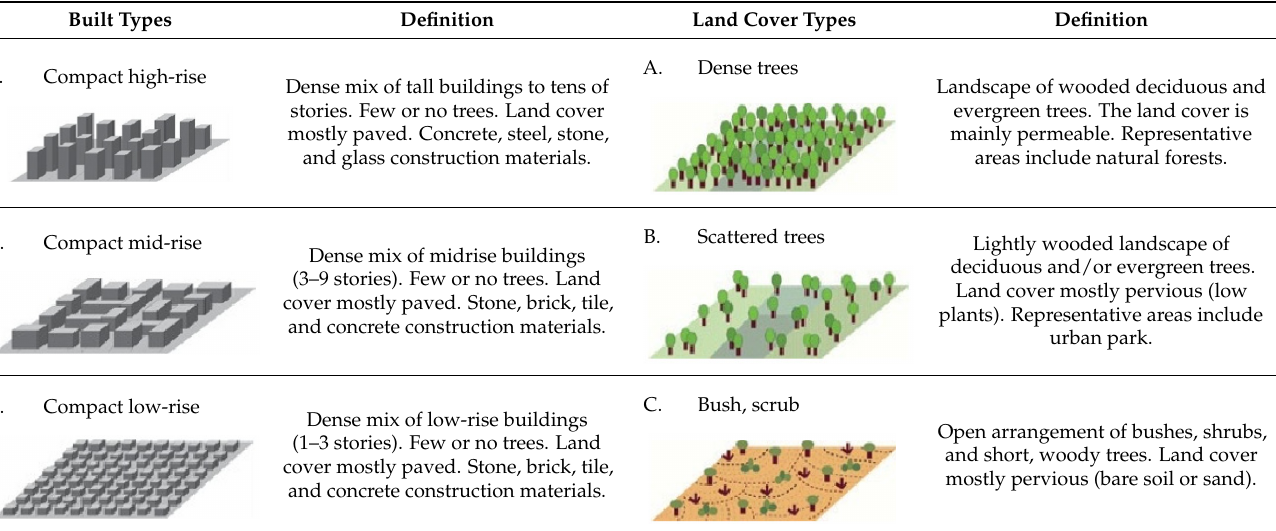
Table A1. Illustration of LCZs and corresponding image